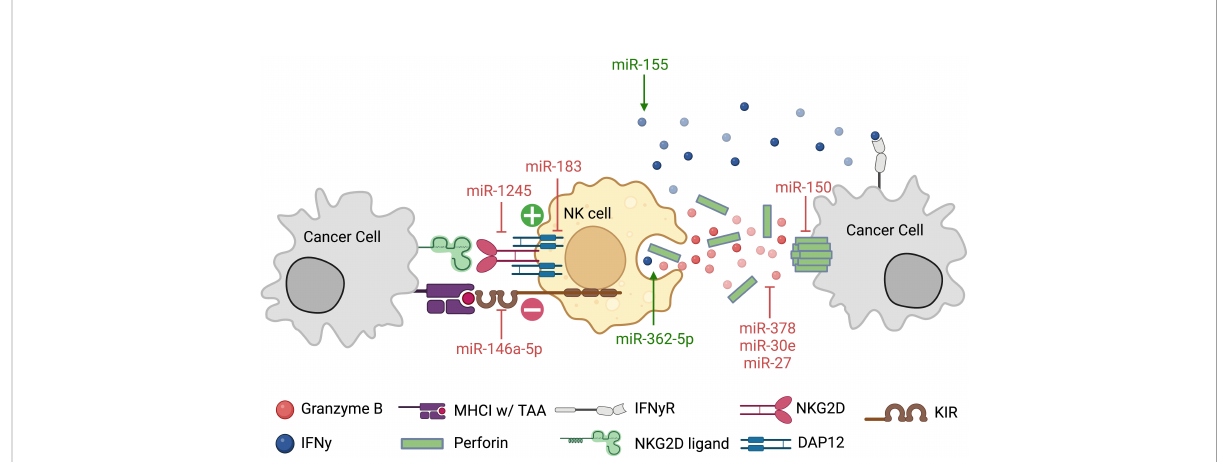
FIGURE 3 Natural killer cell miRNAs regulate tumor cell recognition and NK cell function. NK cells have many surface stimulatory and inhibitory molecules required for recognizing and targeting cancer cells. Not only do miRNAs regulate these molecules, but they also regulate the adaptor proteins, DAP12, and effector molecules, including IFN- g , Gzmb, and